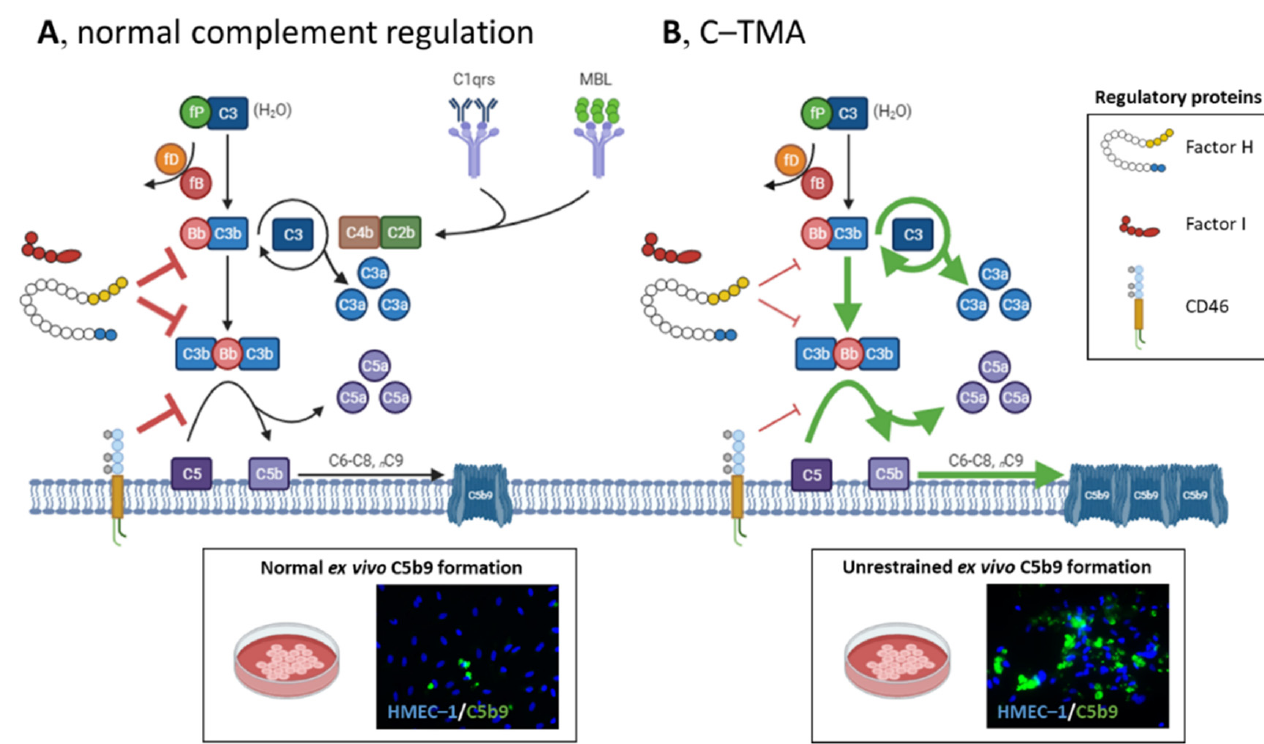
Figure 2. Schematic overview of complement activation and regulation in health and disease. ( A ) The complement system can be initiated via the classical (C1qrs), lectin (MBL), and alternative pathways (C3), converging to C3. The alternative pathway is a spontaneously and continuously active surveillance system operating in the circulation and on the cell sur- face. C3 (H 2 O) binds factor B (fB) and factor D (fD), and the latter cleaves fB into Bb, the serine esterase that cleaves C3 into C3a and C3b. C3’s thioester domain located in C3b can bind to the cell surface (e.g., microbes), providing a platform to form the C3 convertase of the alternative pathway (i.e., C3Bb) to cleave more C3, activating an amplification loop. Next,